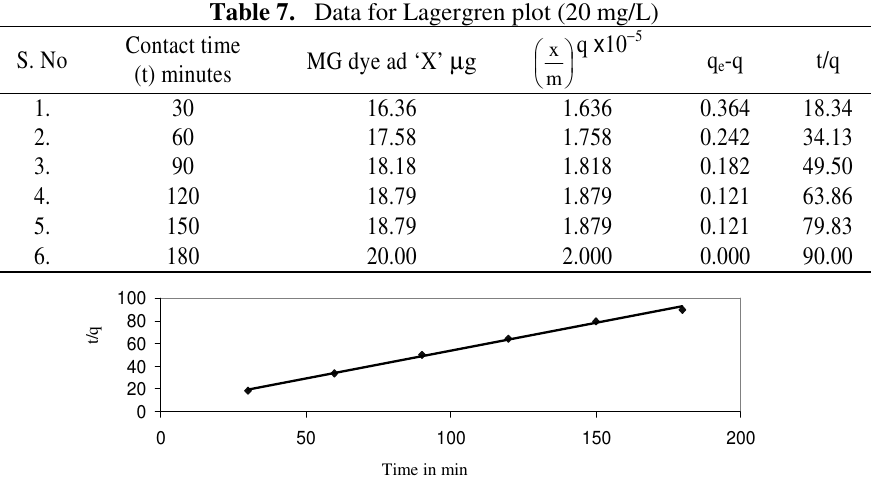
Figure 7. Data for Lagergren plot (20